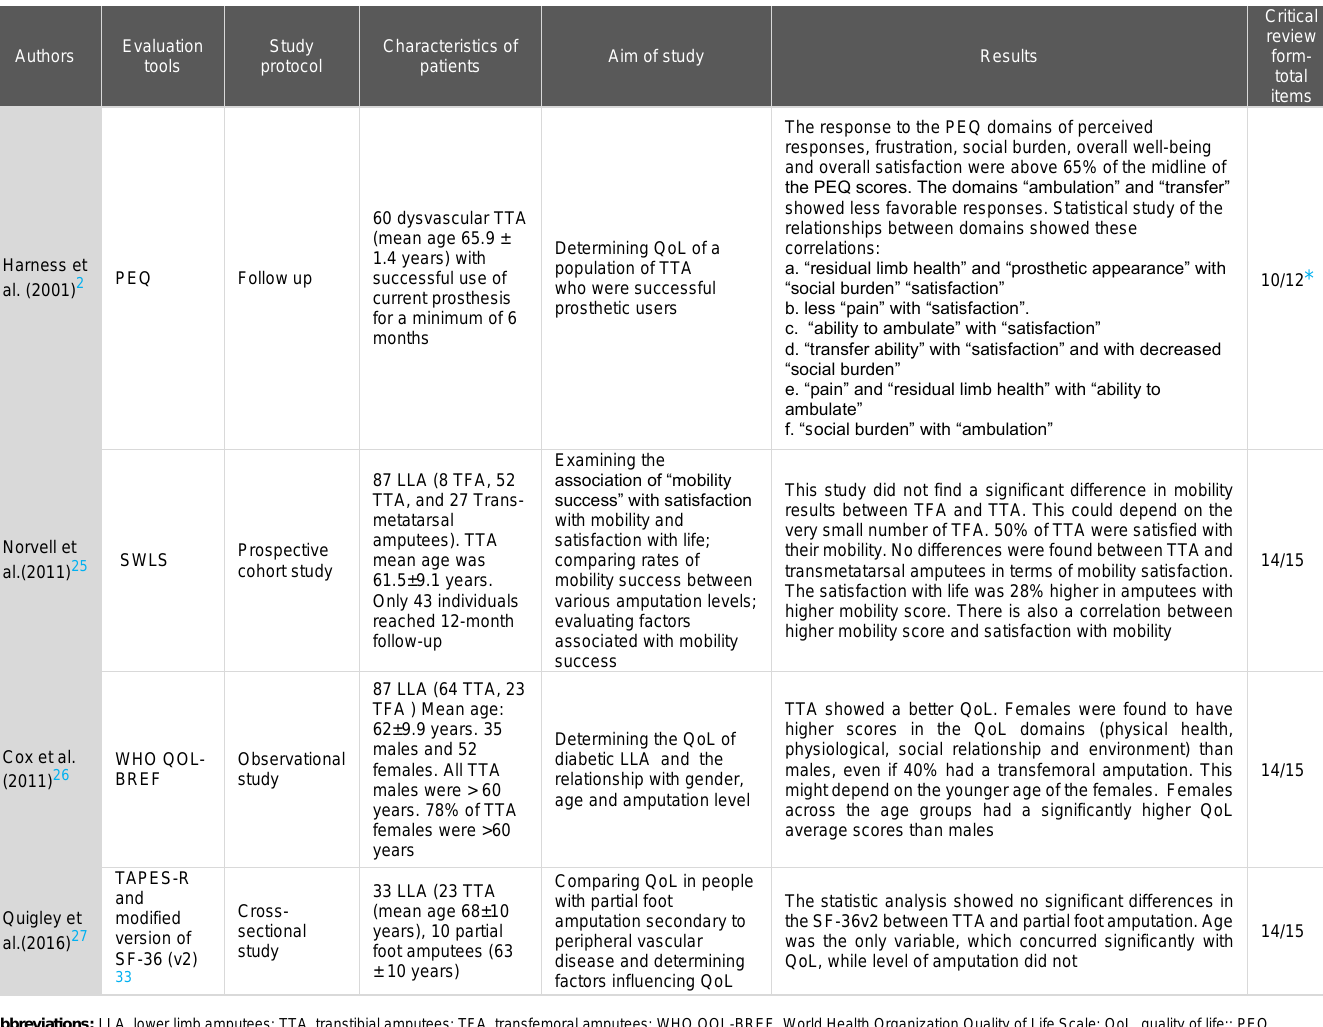
Table 1: Overview of studies reporting QoL data .